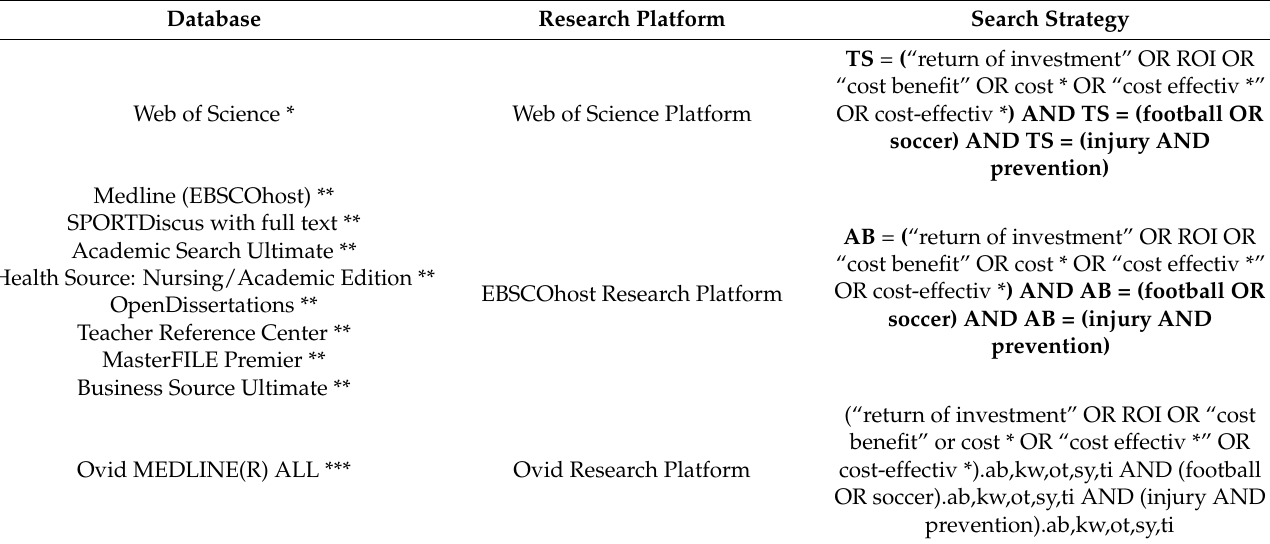
Table 1. The keywords and Boolean operators used in our search